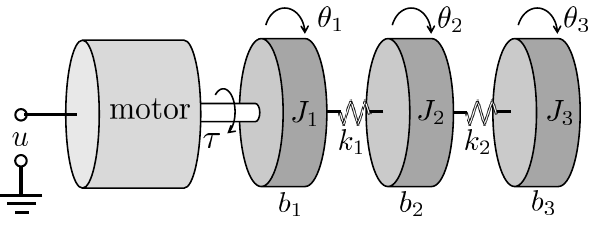
Figure 3. Motor control system of multi-DOF torsion